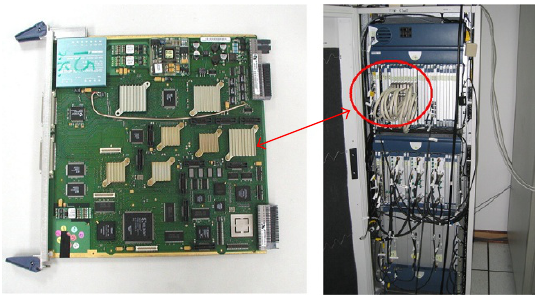
Figure 11: Antenna installation northwest Beijing,